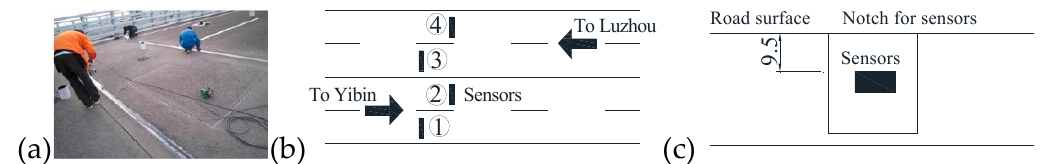
Figure 7. Weigh-in-motion system of a highway bridge: ( a ) site photos; ( b ) plane view; ( c ) elevation view unit: mm.